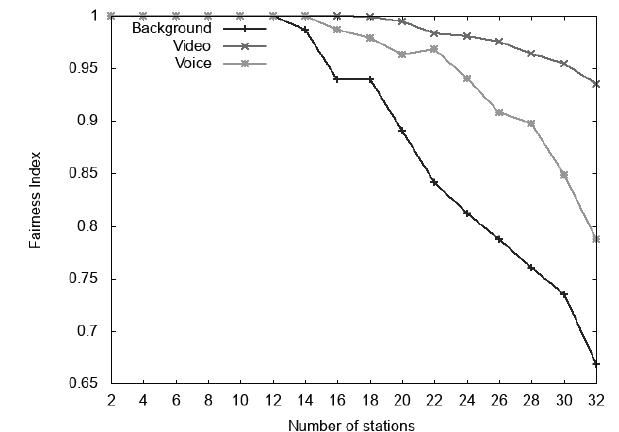
Fig. 11. Collision rate.